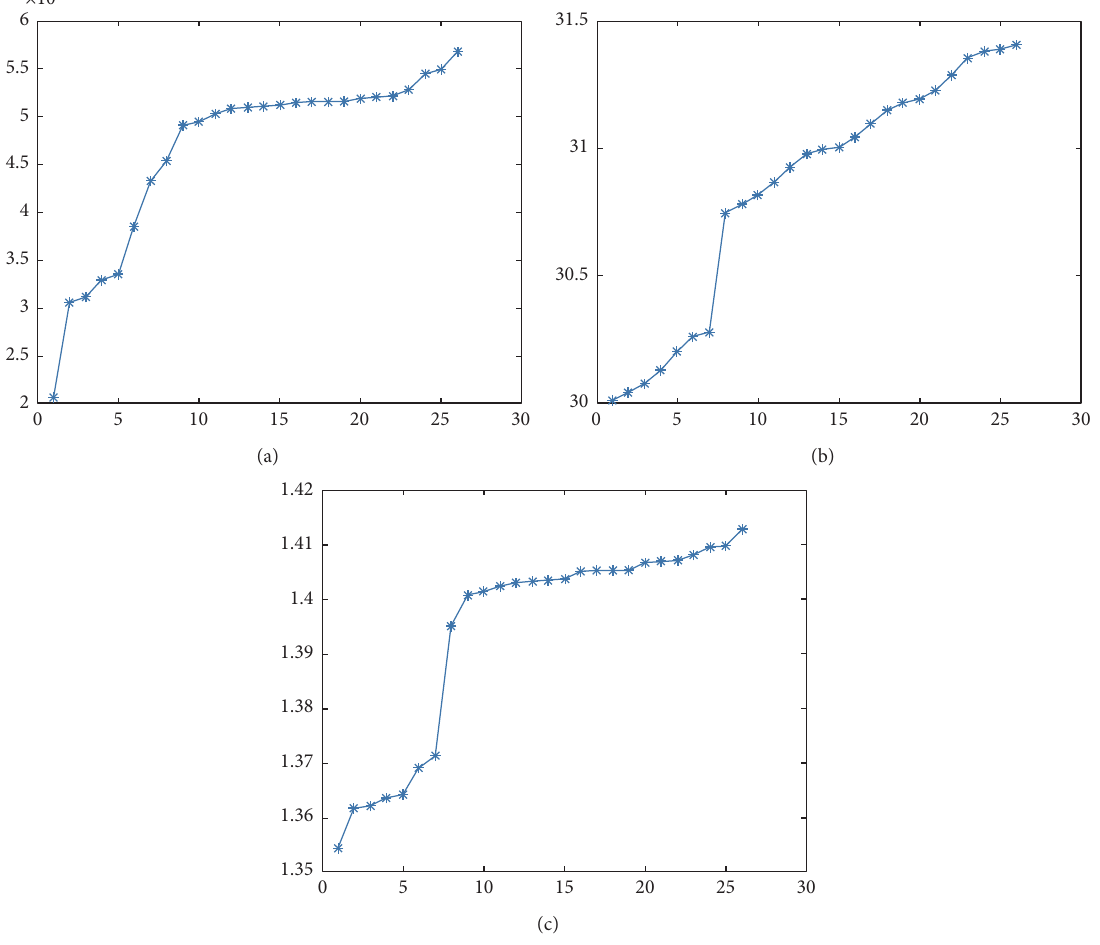
Figure 3: RMSE values of the multistep prediction of three methods: (a) QR, (b) GSO, and (c) SVD.